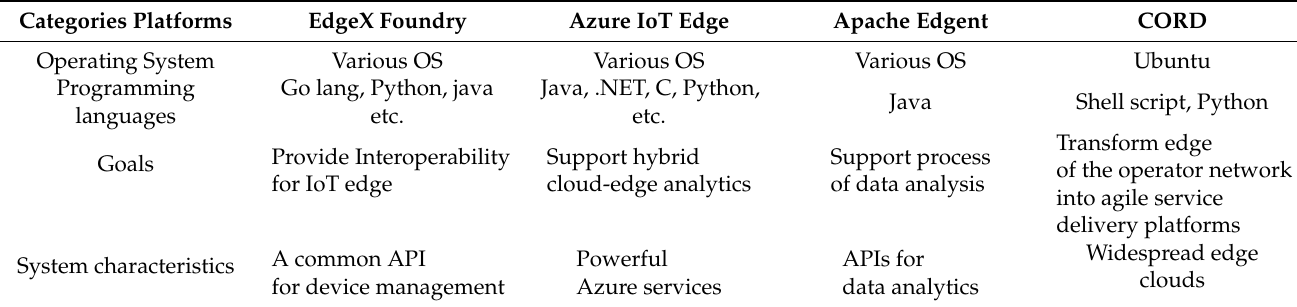
Table 1. Comparison of Open Source Platforms for Edge